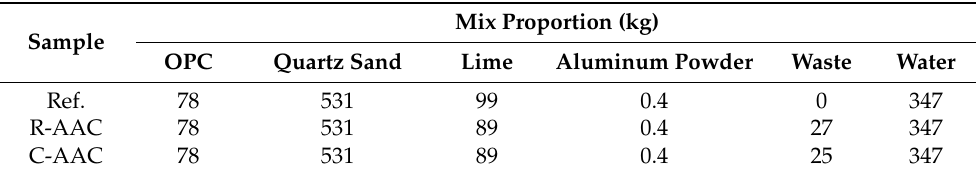
Table 2. Mix proportions of autoclaved aerated concrete (kg/m 3